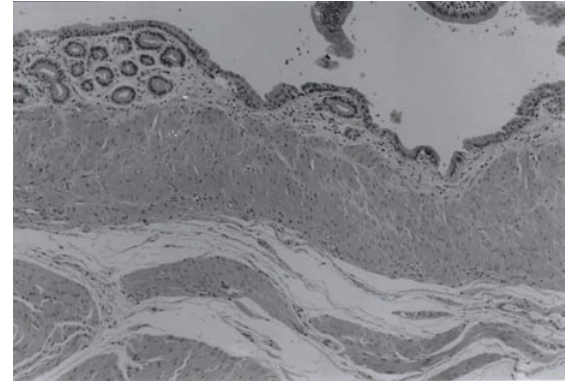
Figure 5. Non-neoplastic epithelium lining blind end projection from the cyst (H&E, magnification x 100).